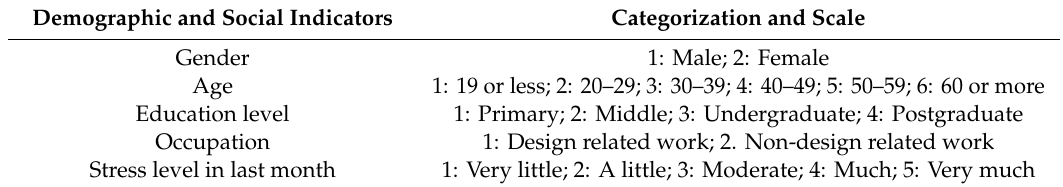
Table 2. Demographic and social data determined by the questionnaire.